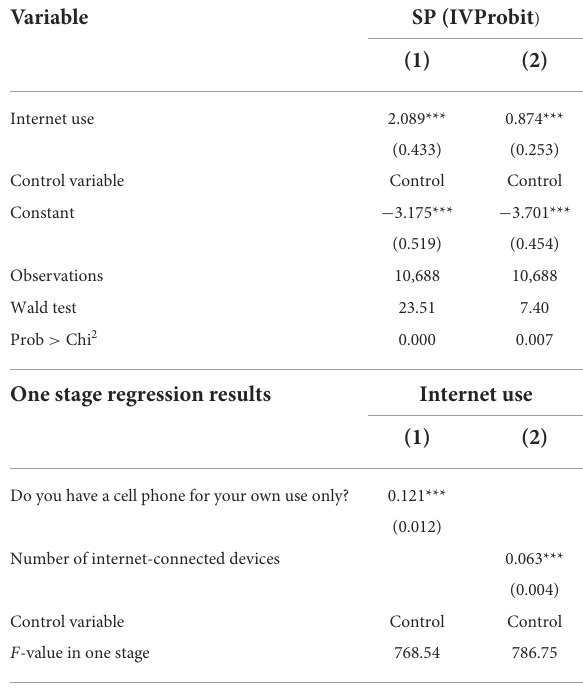
TABLE 3 Instrumental variable method: The impact of internet use on sport participation (SP).